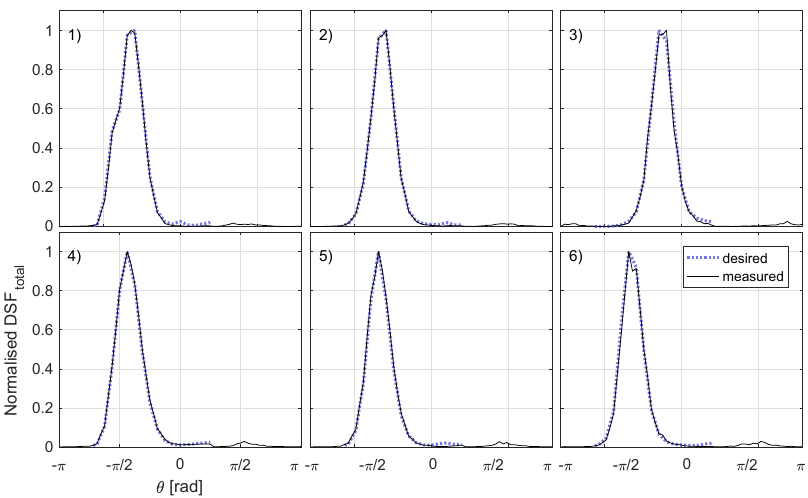
Figure 11. SPAIR method weighted DSF outputs for the extreme sea states, compared with desired. 1 ) to 6 ) correspond to sea states 1 to 6 defined in Table 1.